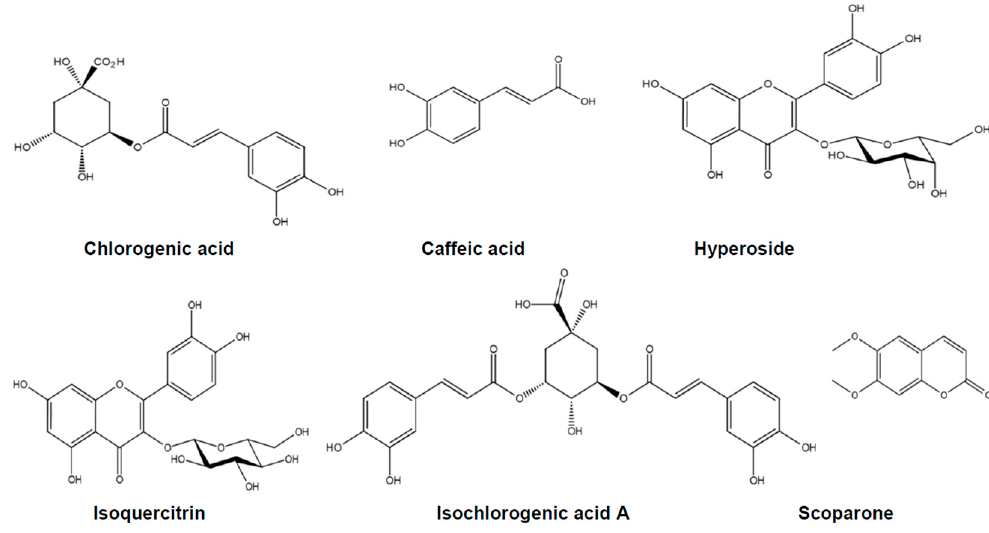
Figure 1. Chemical structures of six compounds.